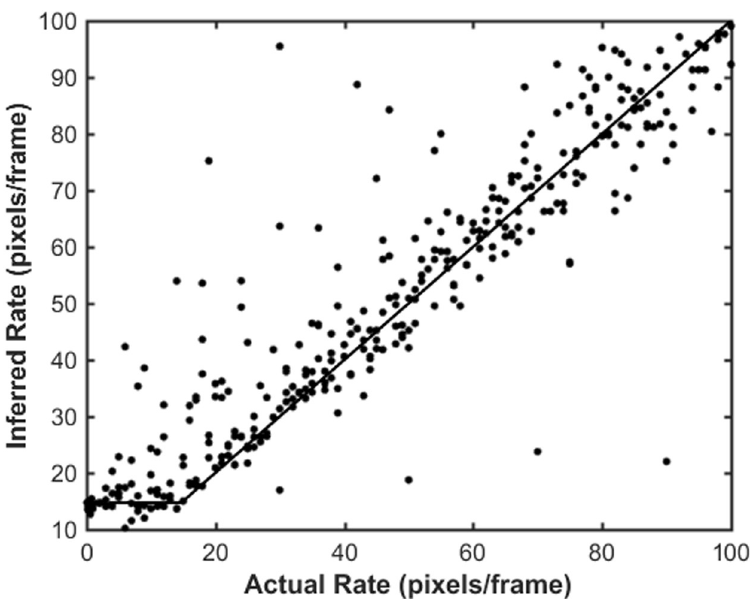
Fig 8. Inferred rate versus actual rate for simulated data. Movies of filaments elongating at different rates, 10 − 4 to 0.1 pixels/frame, were simulated. Kymographs were extracted, edges detected from the simulated data, and the inferred elongation rate determined in the same manner as the experimental kymographs. The data (points) was fitted to Eq (1) (line). For the example shown, the rate was inferred from segments of the boundary 10 temporal pixels in length, and the movie was simulated at a 0.1 Hz frame rate with 100